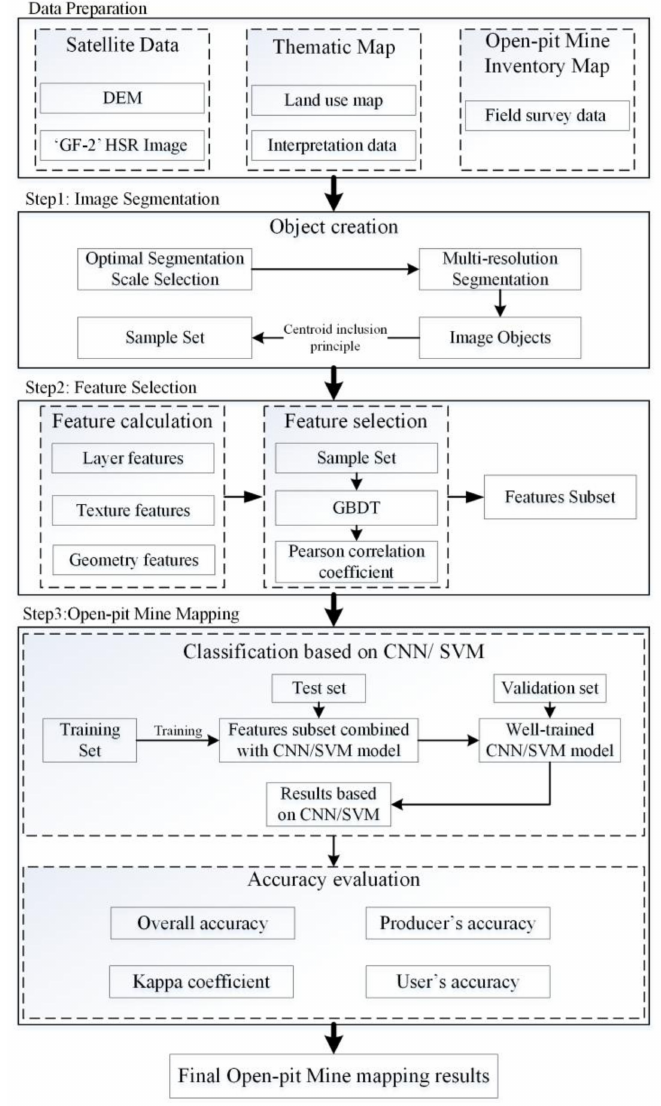
Figure 3. Flowchart of the proposed open-pit mine mapping